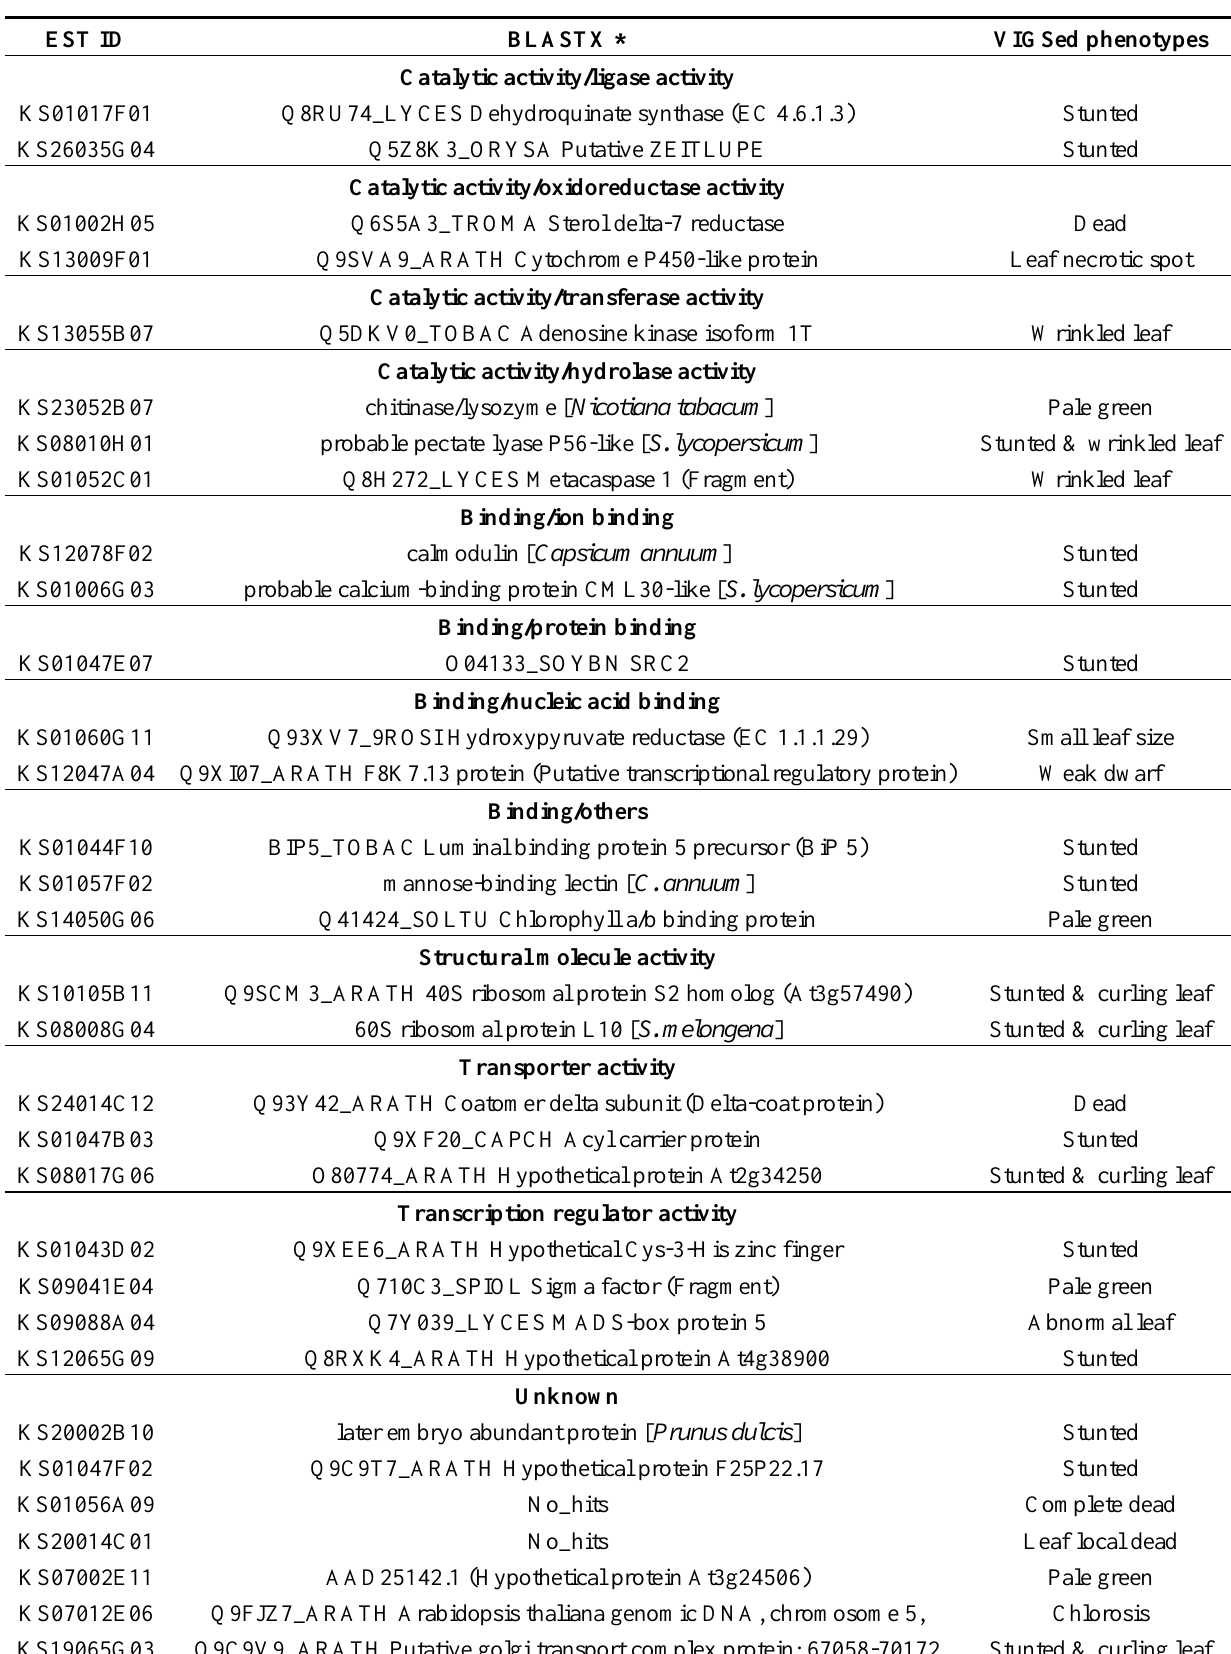
Table 1. Pepper expressed sequence tags (ESTs) showing morphological change in VIGSed N. benthamiana